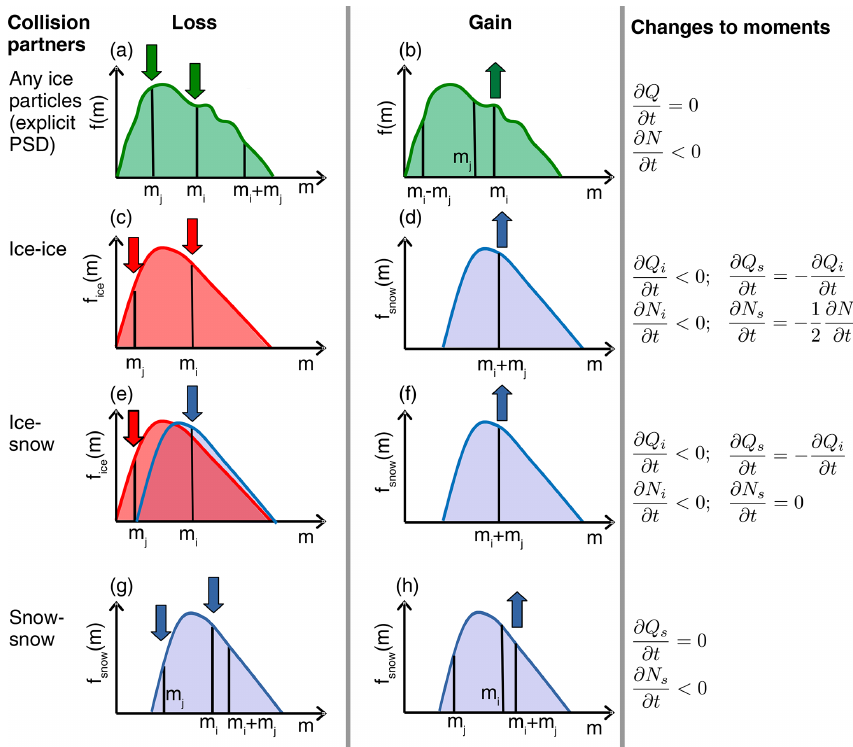
Figure 1. Illustration of the SCE (Eq. 4) for an explicitly resolved PSD m (a, b) and when applied to the cloud ice and snow classes of the SB06 scheme (c, h) . The left column depicts the loss term (second term in Eq. 4) and the middle column the gain term (first term in Eq. 4). The right column shows the sign and connection of the tendency of the bulk moments. Arrows indicate whether the number density is rising or falling at the specified mass. Red lines indicate the ice distribution and blue the snow distribution. The arrows are red if ice particles are collected and blue if snow particles are collected or are created as a result of the